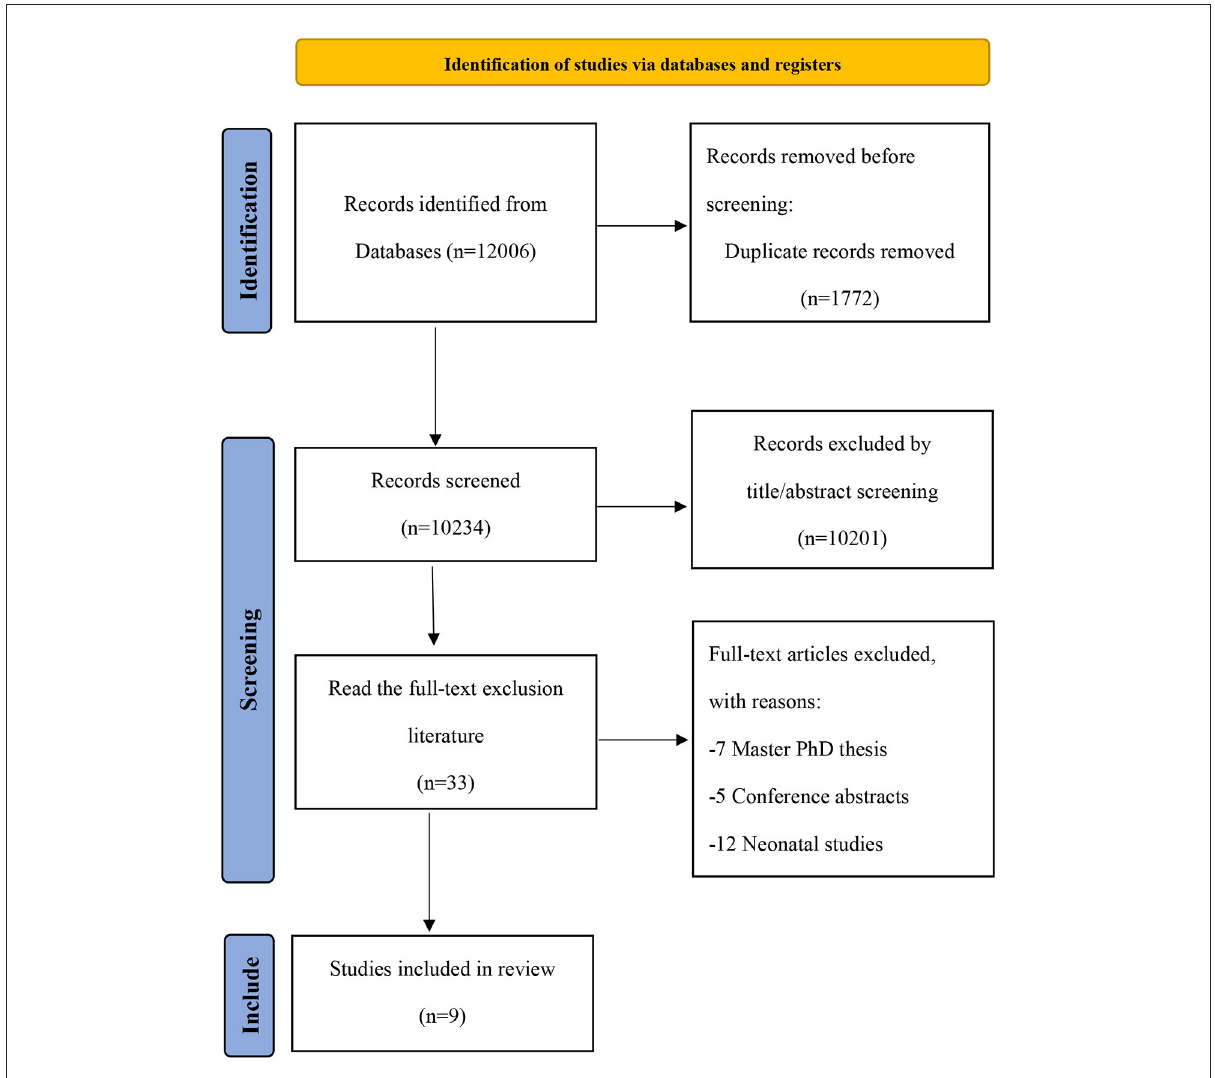
FIGURE1 Literature screening flow